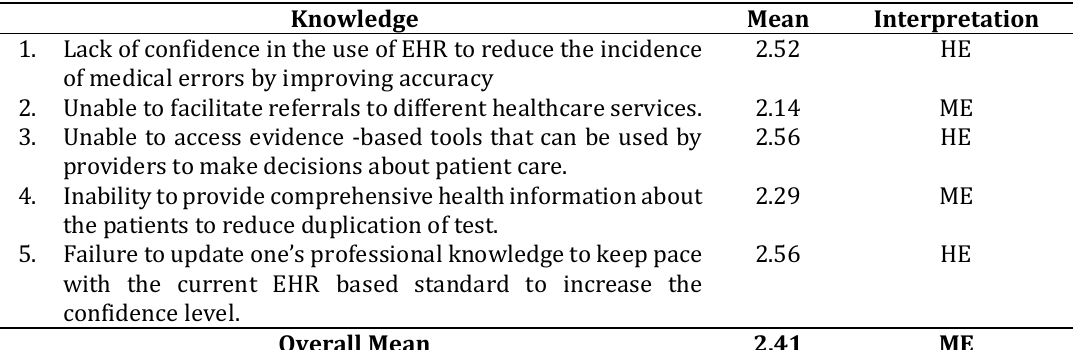
Barriers faced by nurses measured along knowledge on EHR Knowledge Mean Interpretation